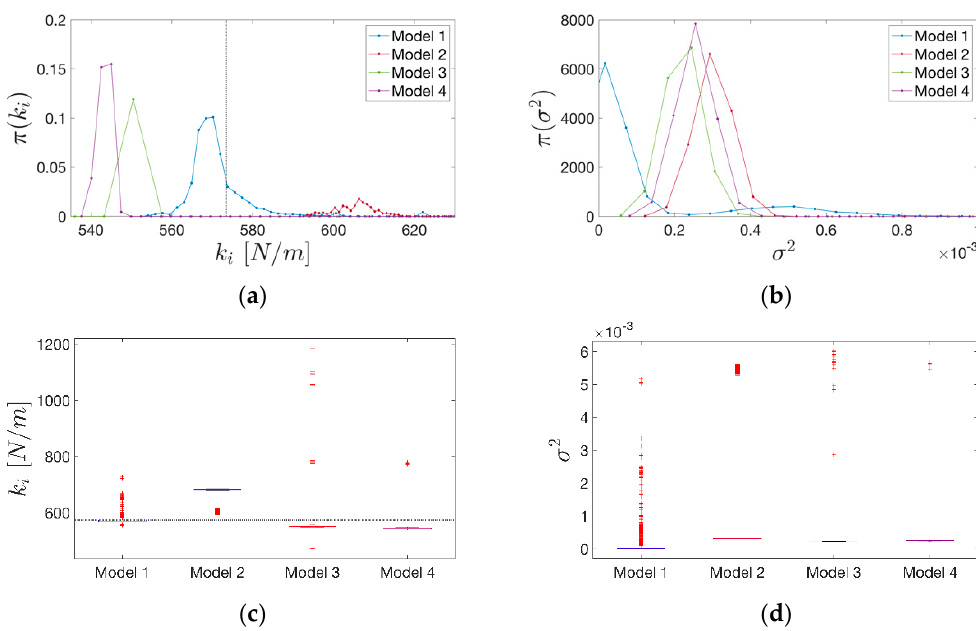
Figure 14. ( a ) Kernel density estimations (KDE) of the initial sti ff ness model parameter k i and; ( b ) of the discrepancy variance σ 2 for each model (medium level of degradation: PGA ≈ 9 m / s 2 , sti ff ness reduction up to 80% of the initial one). ( c ) Boxplot representations (minimum, first quartile, median, third quartile and maximum) of the posterior samples for the model parameter k i and; ( d ) σ 2 . The horizontal and vertical dotted lines in the plots represent the calibrated reference value of the initial sti ff ness.